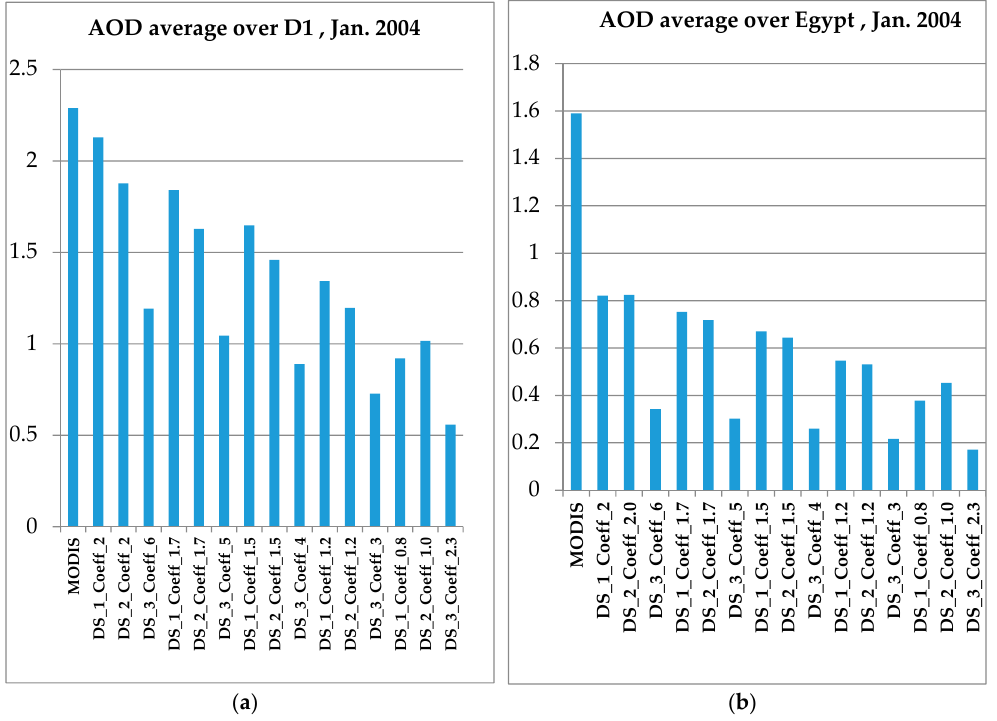
Figure 6. Average AOD from MODIS vs. all fifteen model simulation over ( a ) Egypt ( b ) Domain D1.